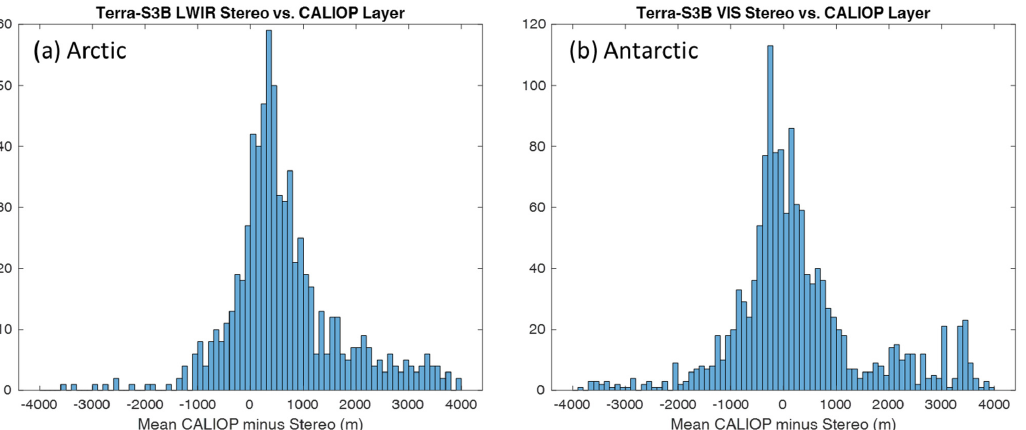
Figure 12. Collocated CALIOP–stereo height differences for 21 December 2021 over the Arctic in LWIR ( a ) and Antarctic in VIS ( b ). The mean differences between the collocated LiDAR and stereo heights are estimated for each stereo-wind site using the MAD method.